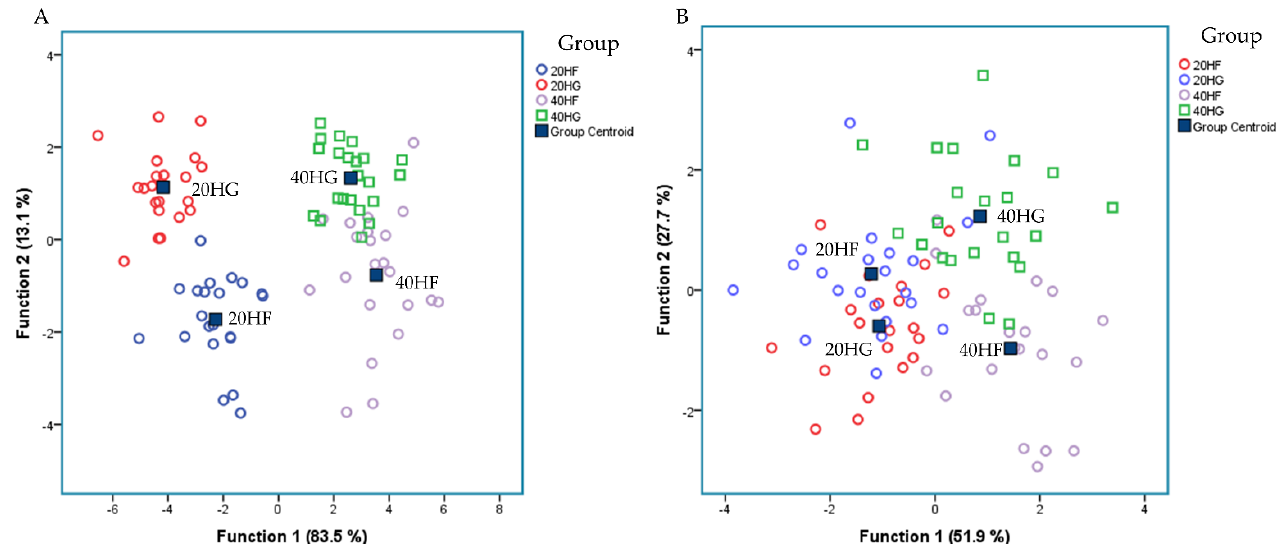
Figure 4. Discriminant plots separating ( A ) the four dietary treatments (20HF; blue, 20HG; green, 40HF; red, and 40HG; pink) according to pooled data of two sampling time (21st and 42nd experimental day) on the rumen fluid fatty acid profile and ( B ) the four dietary treatments (20HF; blue, 20HG; green, 40HF; red, and 40HG; pink) according to pooled data of two sampling time (21st and 42nd experimental day) on the selective ruminal microorganism by qPCR.